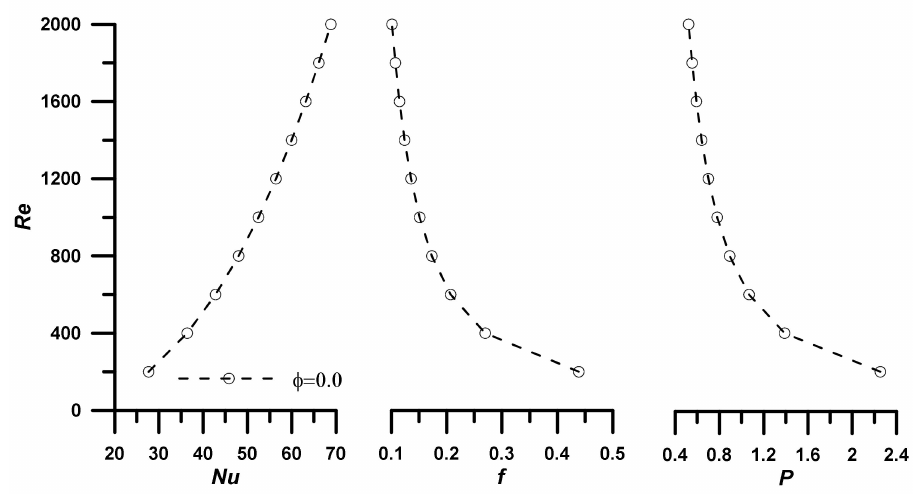
Figure 3. Nusselt number, friction factor, and dimensionless pressure drop at T = 303.15 K and φ = 0.0.